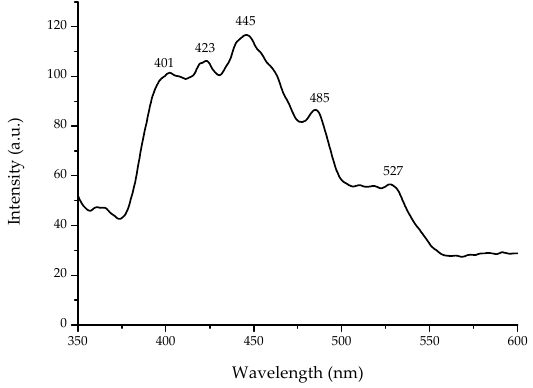
Figure 3. Room temperature fluorescence spectrum of synthesized flower-shaped ZnO nanostructures.